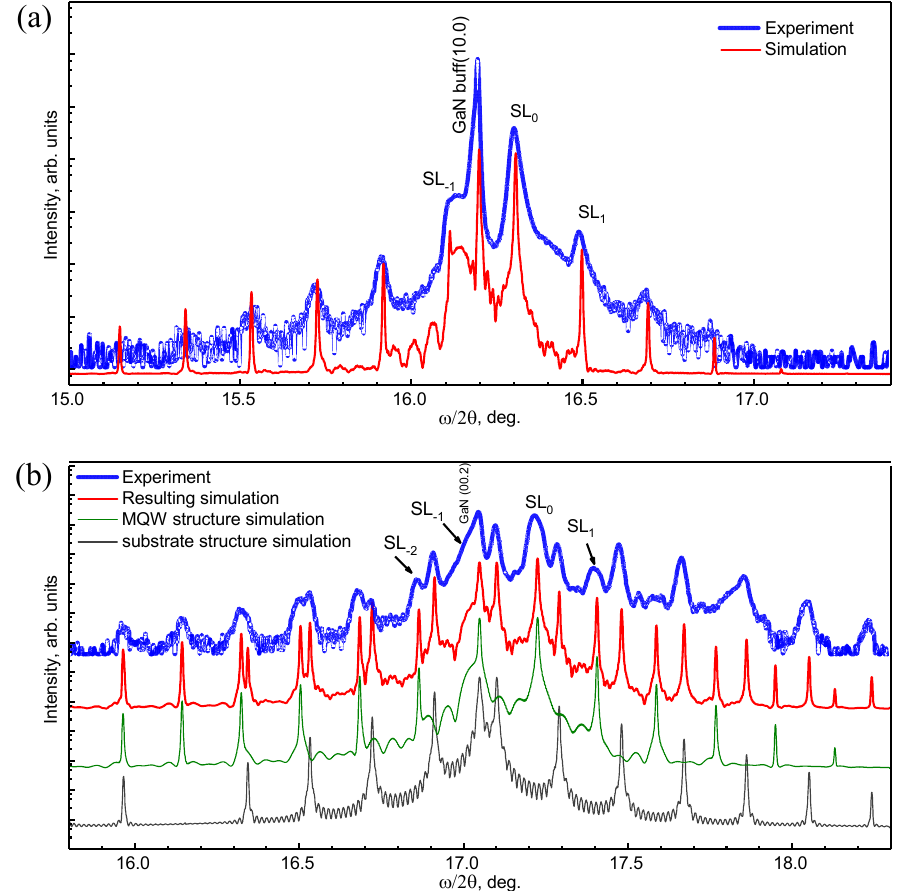
Figure 2. X-ray ω /2 Θ scans of the ( a ) non-polar and ( b ) polar GaN/AlGaN (3 nm/22.5 nm) Figure 2. X-ray  /2  scans of the ( a ) non-polar and ( b ) polar GaN/AlGaN (3 nm/22.5 nm) MQW MQW structures.